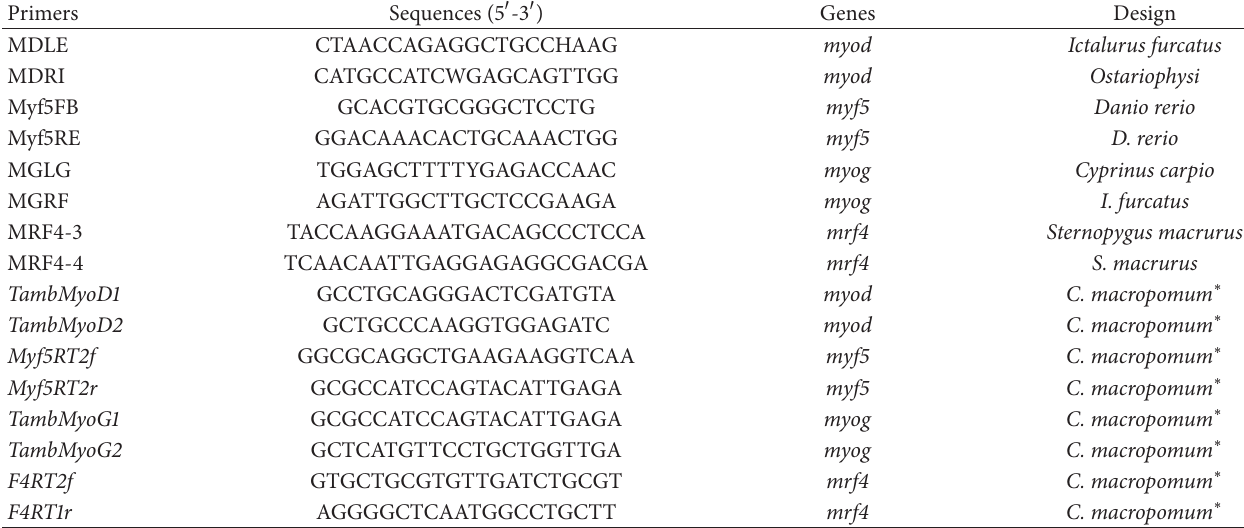
Table 1: Primer sequences used for RT-PCR and qRT-PCR reactions of myod , myf5 , myogenin ( MyoG ), and mrf4